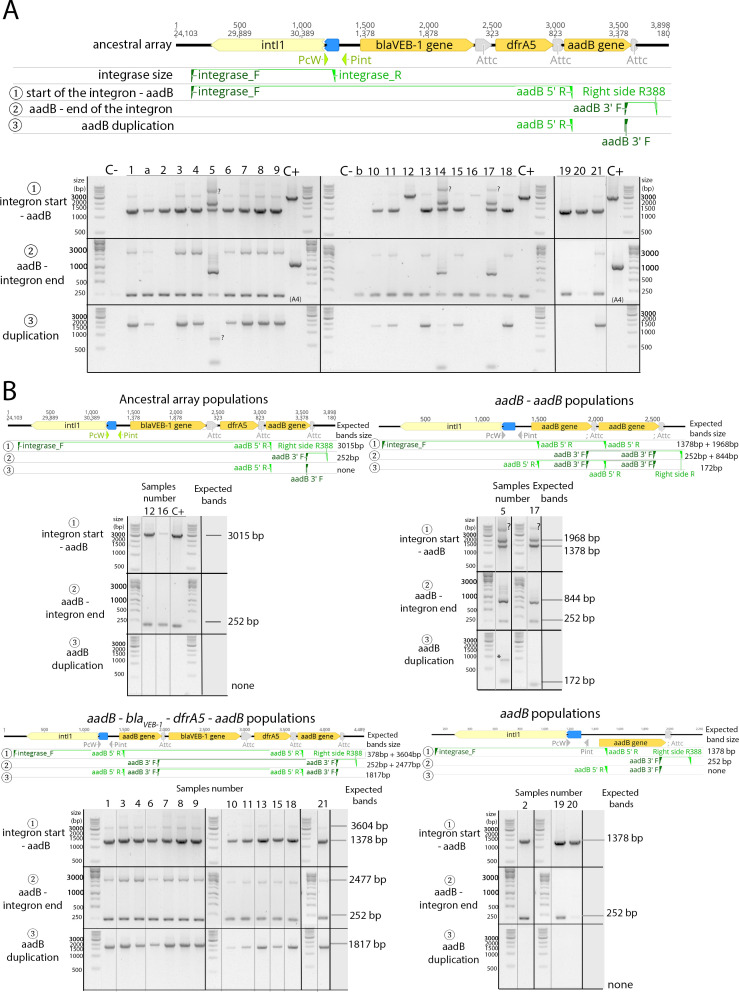
Re-arrangements detection by PCR in ×1024 MIC WTA3 populations.(A) Top: Primer binding sites and amplicons used in the screen for integrase size and cassette re-arrangements. Bottom: Full gels of the PCR screen for cassettes re-arrangements of the ×1024 MIC WTA3 populations. The population number identifier is indicated at the top. Genomic DNA from the WTA3 ancestor was used as positive control, unless indicated. Samples with a letter corresponds to populations latter excluded from the analysis due to detected cross-contamination. The former location of non-relevant lanes excluded from the gels images is indicated by the gray vertical line, and care was taken to keep the vertical alignment within the gels pictures during the figure composition. (B) Predicted amplicons and corresponding populations for each of the cassette array arrangements identified at the ×1024 MIC time point by full genome sequencing. Bands that cannot be explained by the genomic data are indicated by a question mark (?). Black borders separate different gels images. Gray lines indicate where the full gel images were spliced to keep only the corresponding populations while keeping the vertical alignment to the size ladder. Alignments figures created using Geneious version 10.2.